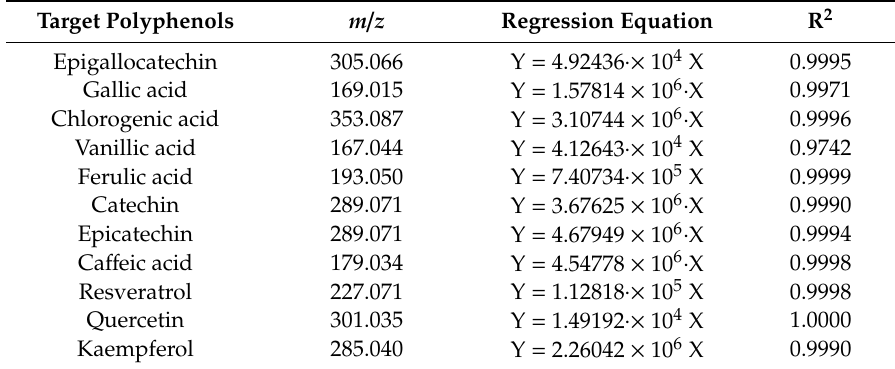
Table 1. Analytical features of ultra-performance liquid chromatography coupled to mass spectrometry (UPLC–MS) method for polyphenol quantification in grape pomace